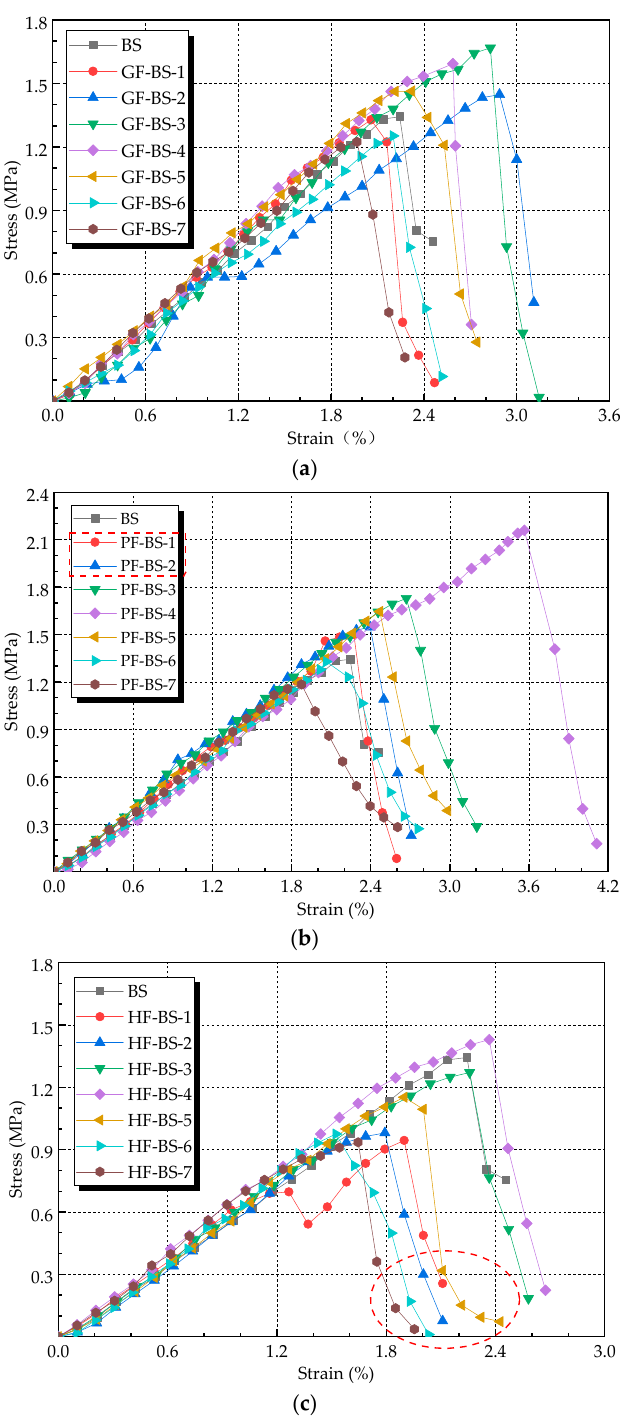
Figure 7. Stress-strain curves of reinforced sand under different fiber types and contents: ( a ) stress- strain curves of the GF-BS; ( b ) stress-strain curves of the PF-BS; ( c ) stress-strain curves of the HF-BS.